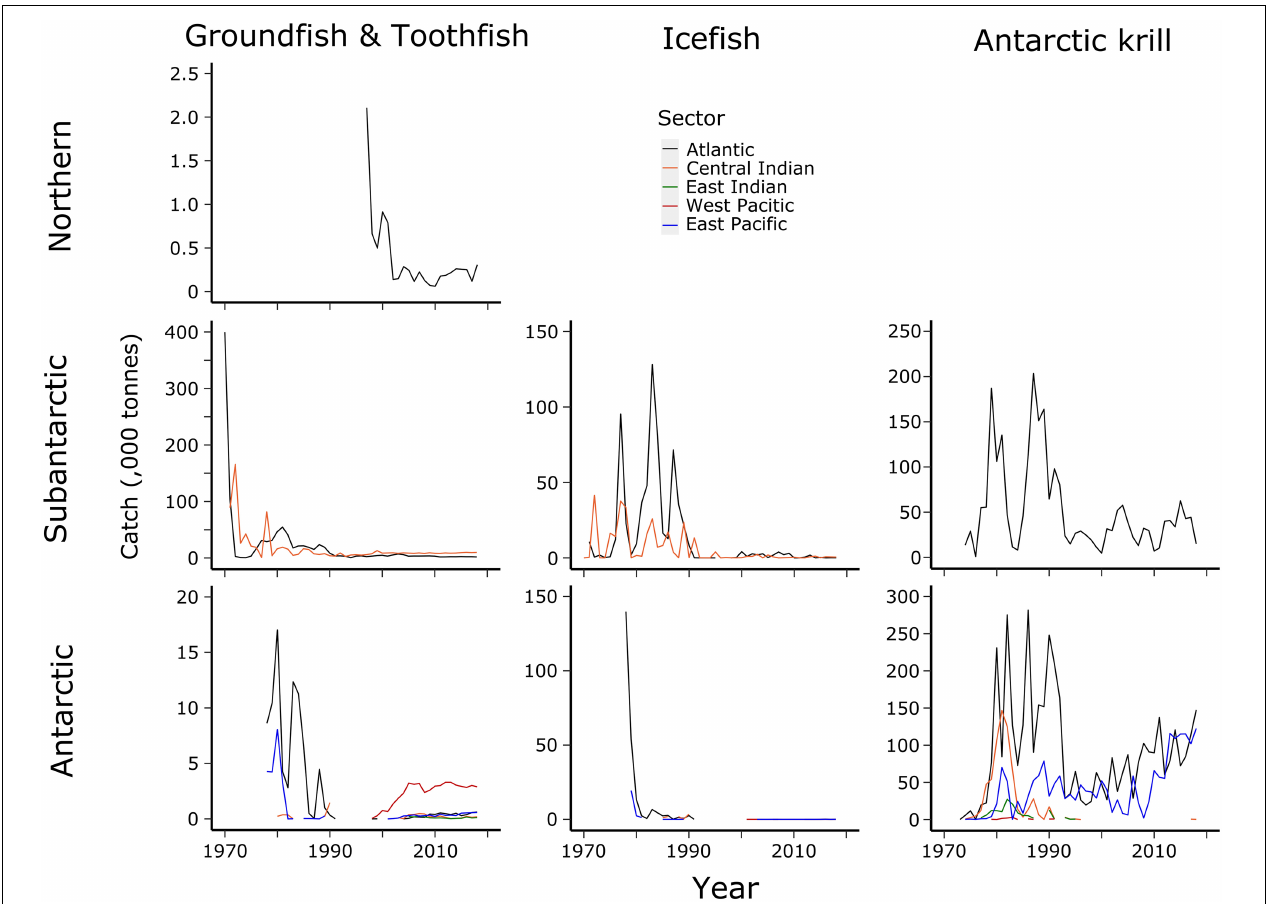
FIGURE 10 | Time Series of catches for target species in each sector (legend in centre top row) for each zone (rows) of MEASO areas (as shown in Figure 2 ). Groundfish and toothfish can be separated at 1991, with groundfish trawling occurring prior to that time and toothfish fisheries (primarily longlining) continuing after that time. Species are those listed in Figure 8